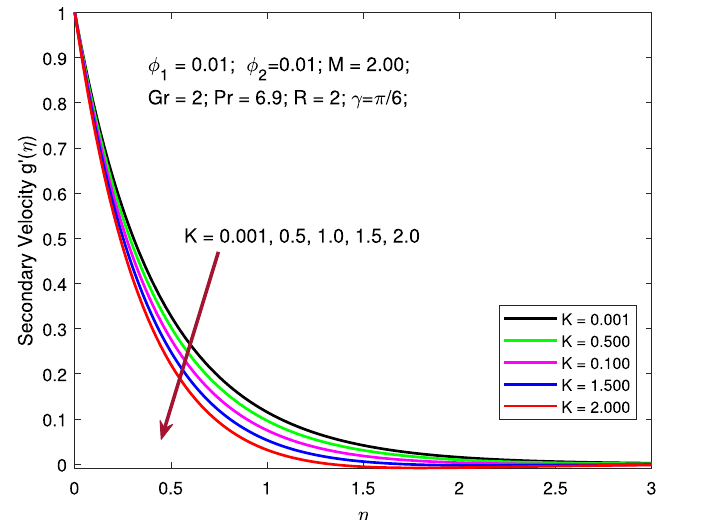
Figure 3. Variation of secondary velocity with Coriolis force.